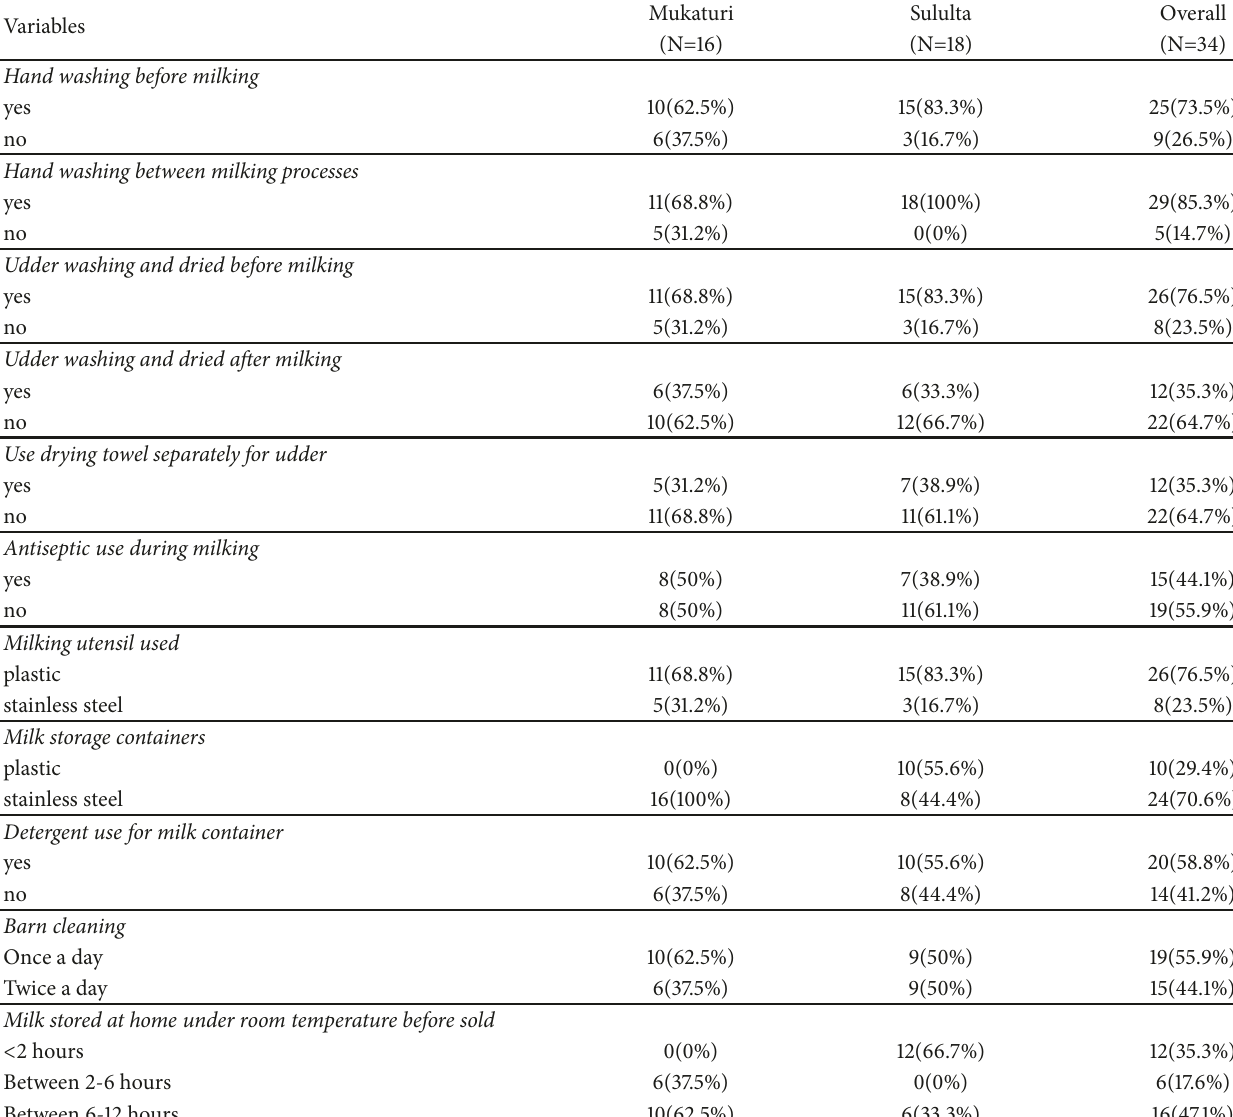
Table 3: Hygienic practices during milking and milk handling practice by milking personnel.